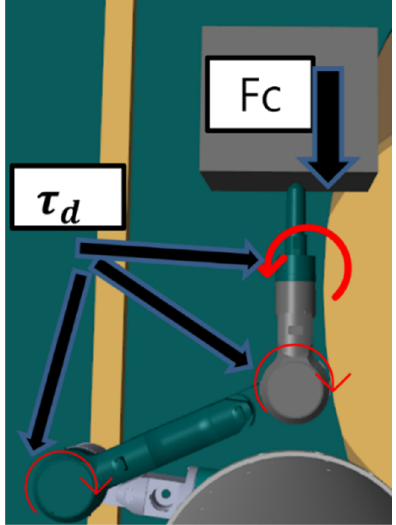
Figure 6. Contact force impact on joints.